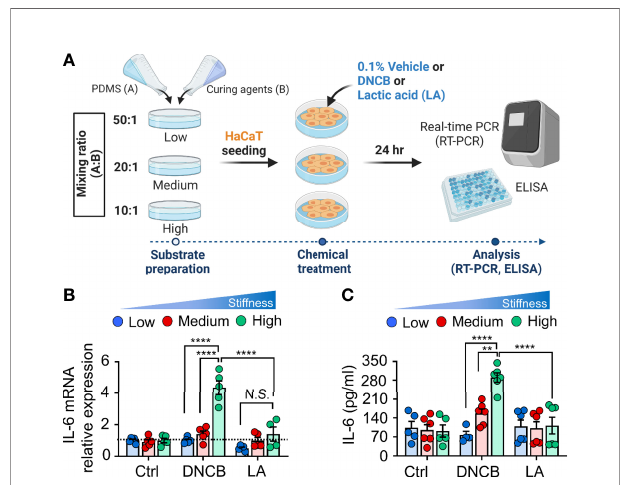
FIGURE 2 | Matrix stiffening enhances IL-6 production in response to DNCB in keratinocytes. (A) The experimental design for chemical and mechanical stimulation of proin fl ammatory response. (B) mRNA expression of IL-6 in HaCaT cells cultured on substrates with low (20 kPa), medium (500 kPa) and high (1200 kPa) stiffness in response to 0.1% DMSO (control, Ctrl), DNCB, and lactic acid (LA). Data are normalized to 0.1% DMSO-treated cells (Ctrl) on substrates with low stiffness. (C) ELISA for IL-6 in the culture supernatants from HaCaT cells cultured on substrates with low, medium, and high stiffness in response to 0.1% DMSO (Ctrl), DNCB, and LA. n = 4~6/group. Data represent the mean ± S.E.M. ** p < 0.01; **** p < 0.0001 by two-way